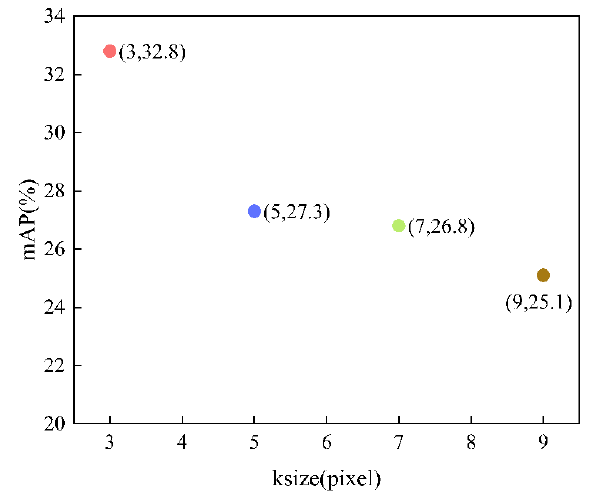
Figure 11. Variation of mAP of the model with ksize.